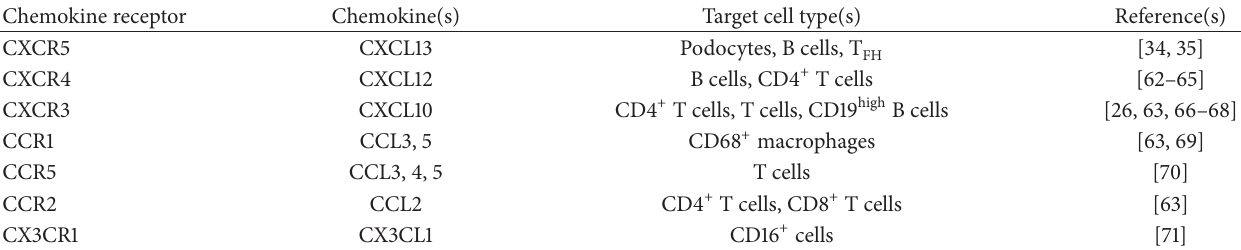
Table 2: Chemokine receptors and chemokines likely to mediate cell infiltration into the kidney in human